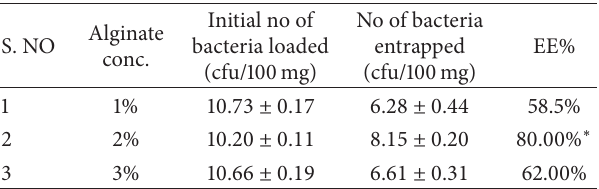
Table 2: The drug entrapment efficiency (DEE) of probiotic AL and AL-CA beads ( 𝑛 = 6